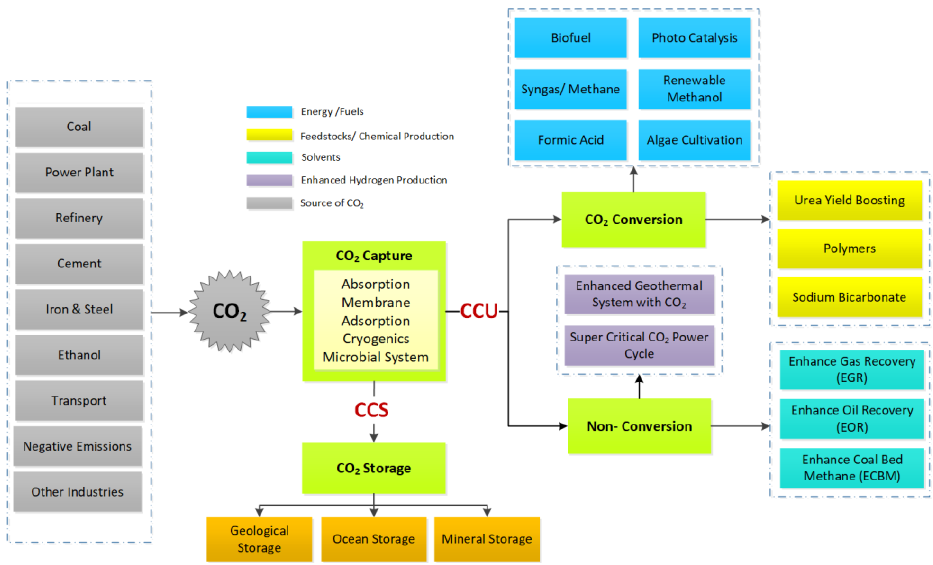
Figure 3. The CCUS schematic diagram.